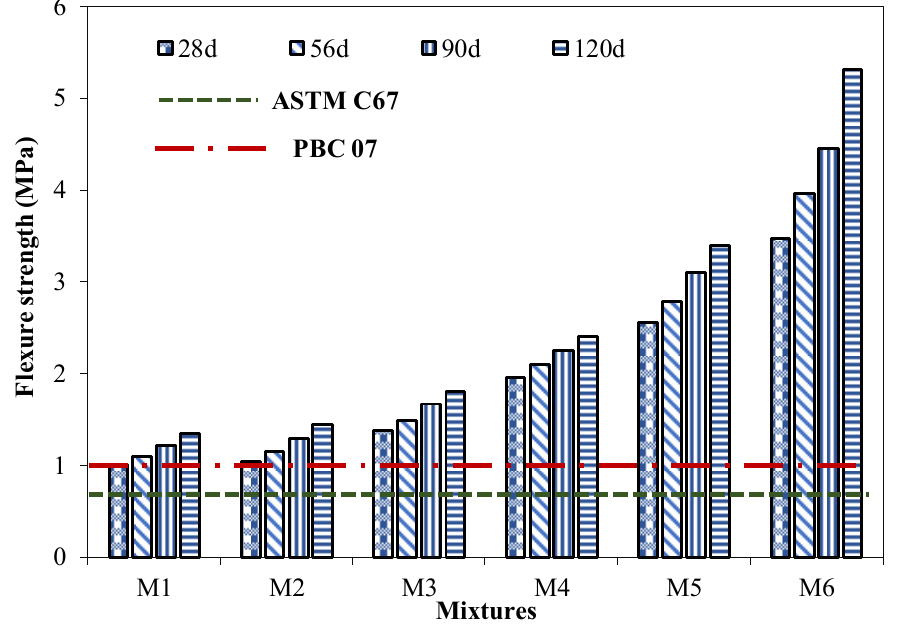
Figure 11. Flexural strength of the brick specimens with age.